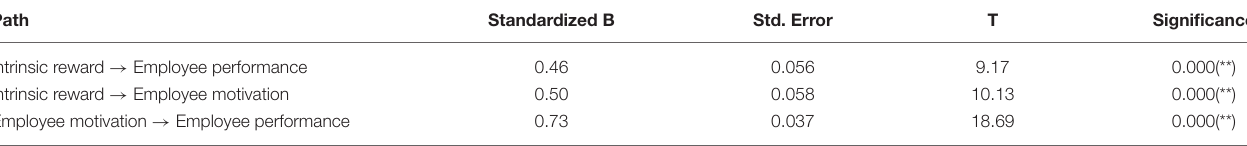
TABLE 5 | Regression coefficients for a direct relationship of variables for testing hypotheses 1–3.